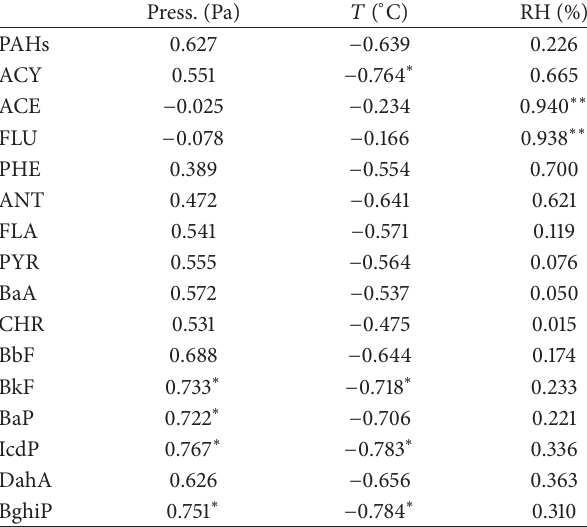
Table 4: The correlation coefficients between particulate bound- PAH concentrations and meteorological parameters.